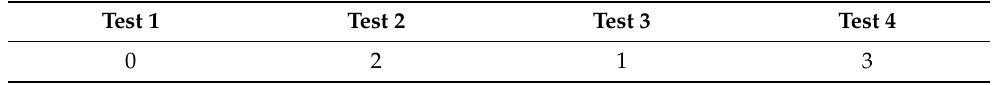
Table 1. Example 1: Results from four tests.